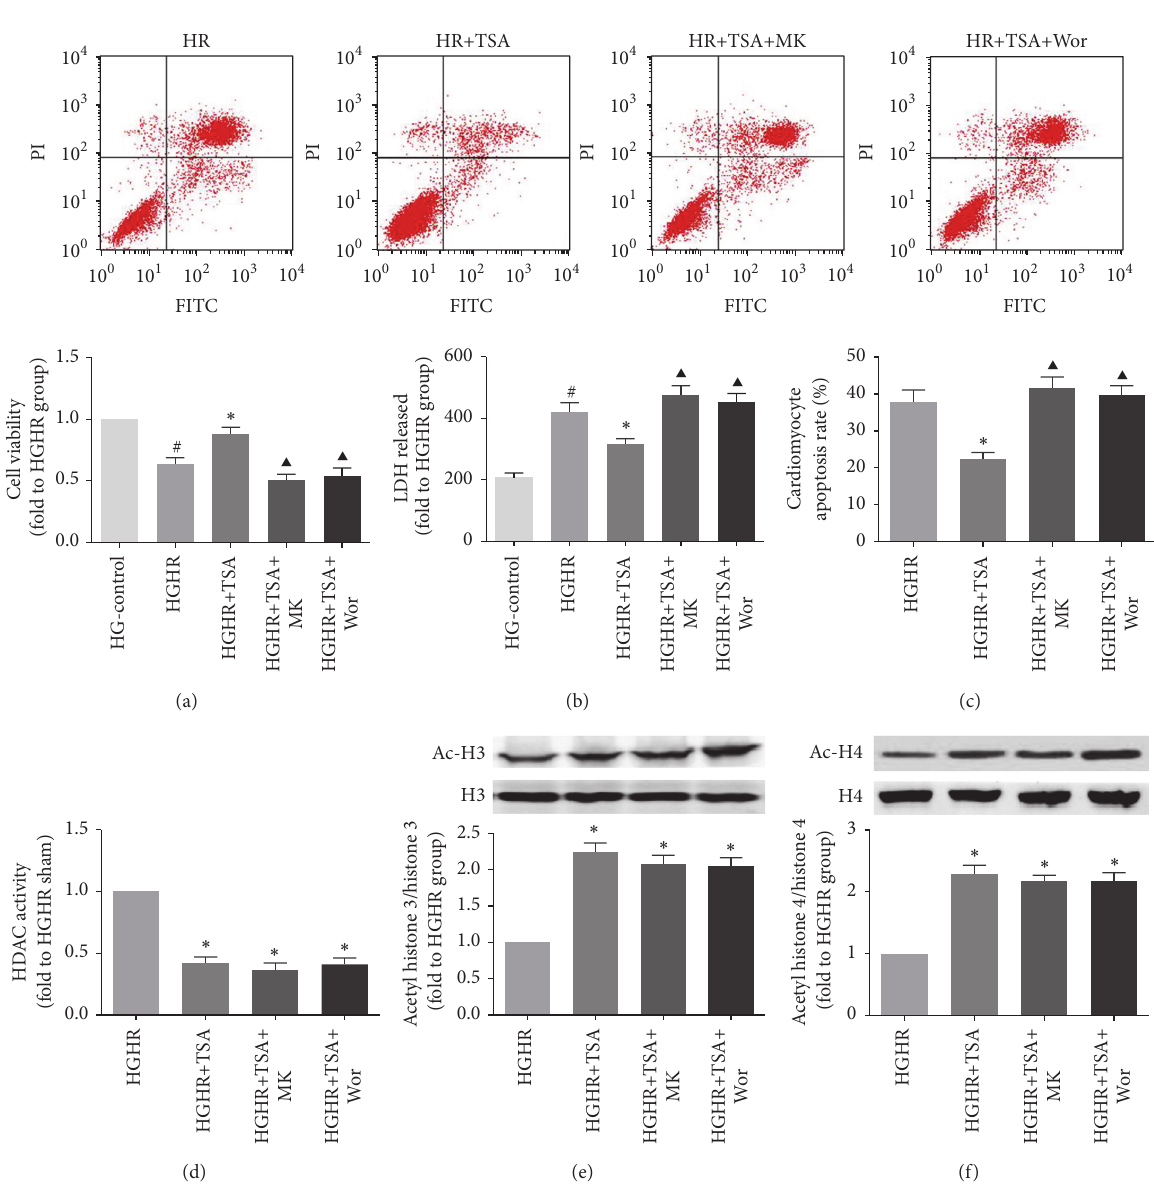
Figure 7: TSA administration has a protective effect on cardiomyocytes. Apoptosis in H9C2 cardiomyocytes was assessed by cell viability (a) and LDH leakage (b) and apoptosis rate (c) in each group. Cell lysate HDAC activity of each group was measured (d, e, f). Representative Ac-H3/H3 and Ac-H4/H4 Western blots images and protein levels analysis. GAPDH served as the loading control. All values are presented as the mean ± SEM, 𝑛 = 6 /group. # 𝑝 < 0.05 versus HG-Control group. ∗ 𝑝 < 0.05 versus HGHR group. 󳵳 𝑝 < 0.05 versus HGHR+TSA